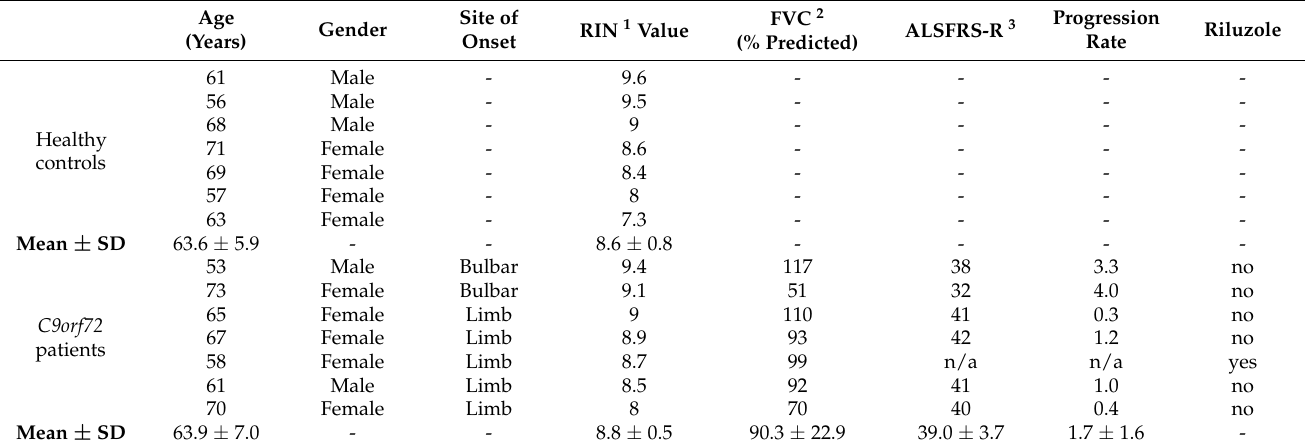
Table 1. Human samples